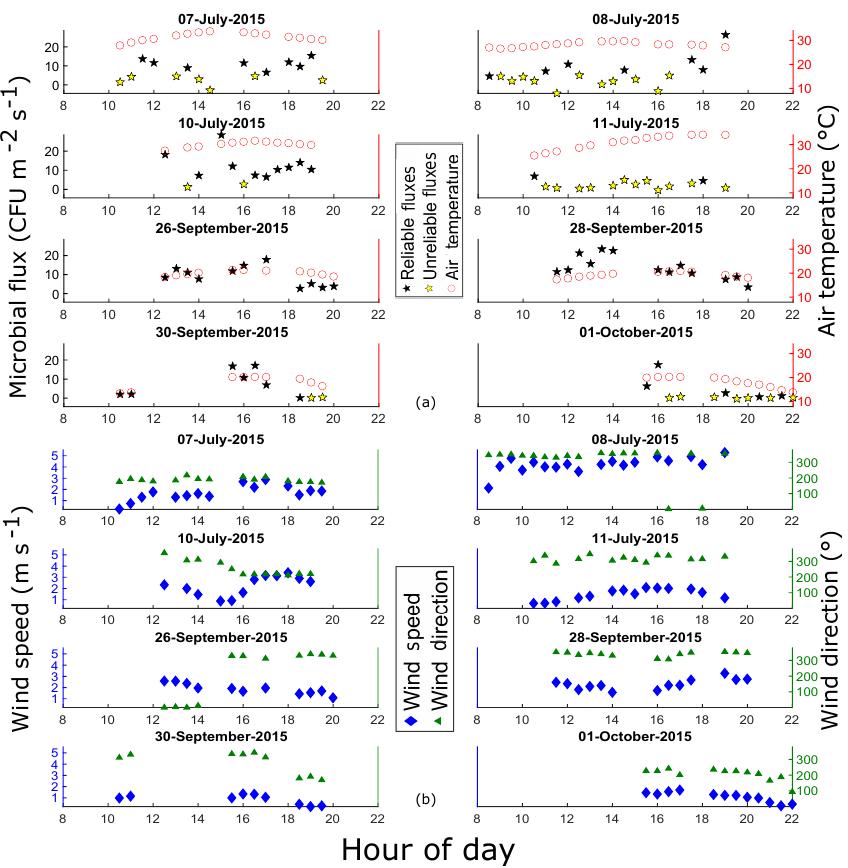
Figure 3. Dynamics of observed microbial fluxes, air temperature, wind speed and wind direction in the 2015 field campaigns. Panel (a) shows the time series of air temperature and microbial fluxes for July and September–October 2015. Unreliable fluxes are those below the MRG. Panel (b) shows the time series of wind speed and wind direction for the same periods. Table 2. Results of the optimization procedure and the sensitivity analysis. The first row reports the value chosen by the optimization for the parameters in the column headers, while the second row reports the sensitivity value for each